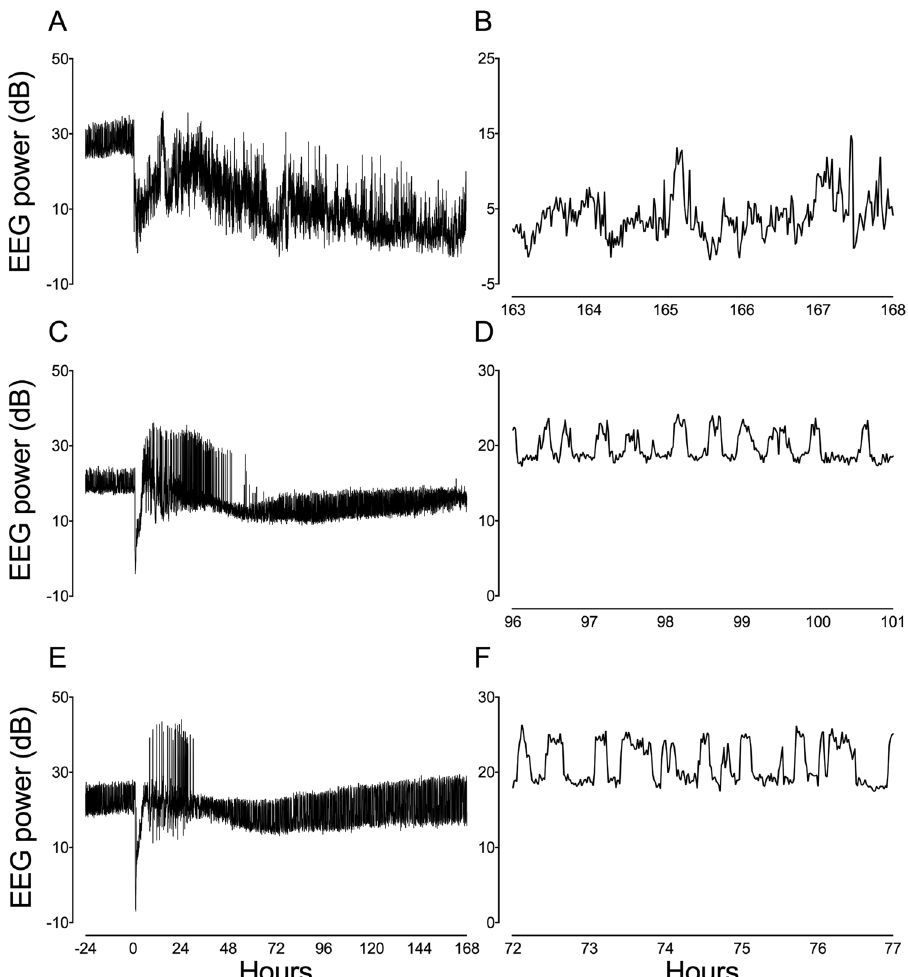
Figure 1. Representative continuous EEG and sleep state cycling data (1 min averages) from a fetus in the ischaemia + vehicle group ( A,B ). Note the continued suppression of EEG power after asphyxia (0 h) followed by a large prolonged rise in EEG activity between 10 and 168 h, reflecting electrographic seizure activity, and no sleep state cycling by 168 h (7 d). In the examples from a fetus in the ischaemia + short infusion ( C,D ) and ischaemia + long infusion groups ( E,F ), the pattern of seizure activity was much more discrete than after ischaemia + vehicle and sleep state cycling returned by 96 and 72 h (days 4 and 3),